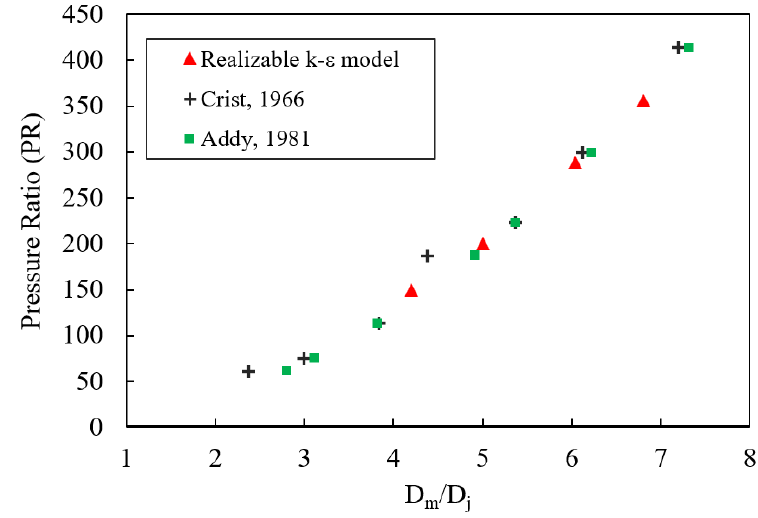
Figure 7. Pressure ratios vs. non-dimensional Mach disk diameter [57,59].